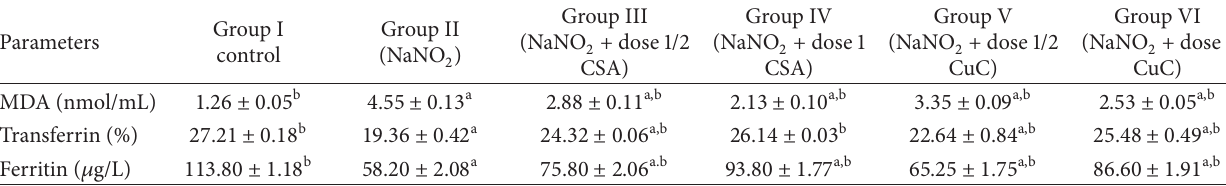
Table 2: The serum biochemical parameters in each experimental group.